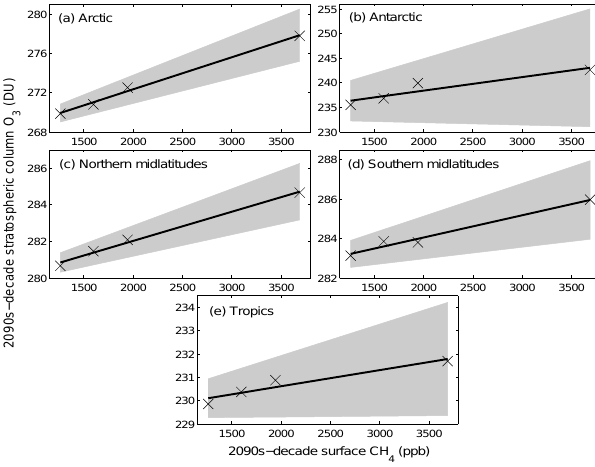
Fig. 8. Similar to Fig. 7, but for 2090s-mean stratospheric column ozone vs. 2090s-mean surface CH 4 for the four CH 4